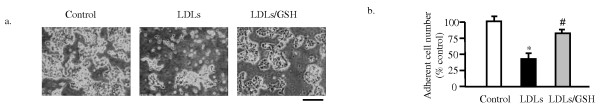
GSH reverses the apoptosis induced by LDLs in MIN6s. The MIN6 cells were exposed to the 100 μg/ml of LDLs alone or the combination of LDLs and 2 mM of reduced glutathione (LDLs/GSH) for 48 hours. The cell images were obtained with a phase-contrast microscope at 48 hours after the exposure. Bar, 25 μm (a). The numbers of adherent cells were expressed as percentage of the number of control cells (b). Mean ± SD (n = 3). *: p < 0.05 vs. the levels of LDLs loaded-cells.